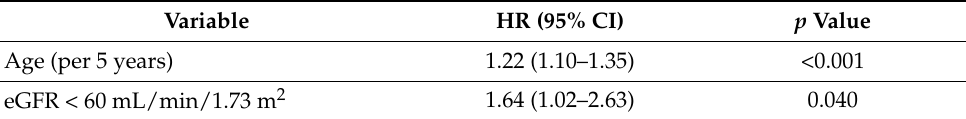
Table 3. Results of Cox multivariate regression analysis for variables significantly and independently associated with main outcome. Abbreviations: eGFR: Estimated GFR.